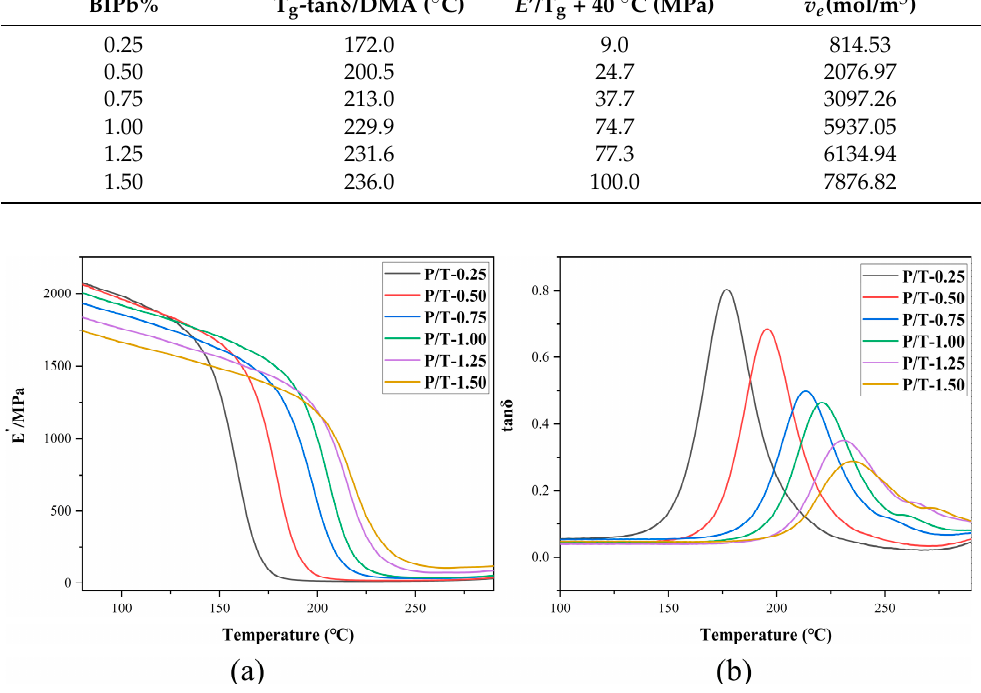
Figure 8. ( a ) The storage modulus ( E (cid:48) ) curves of different initiator mass fractions samples; ( b ) the tan δ curves of different initiator mass fractions samples.